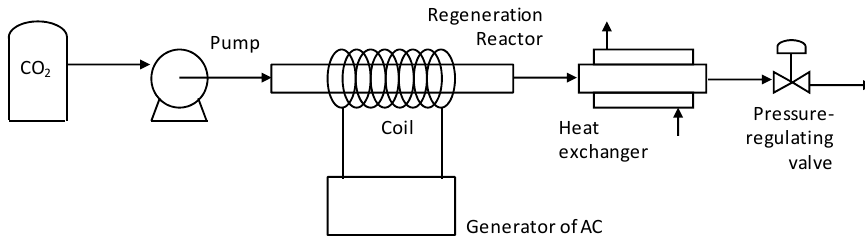
Figure 1. Schematic of the installation used for the supercritical CO 2 (SCCO 2 ) regeneration experiments.